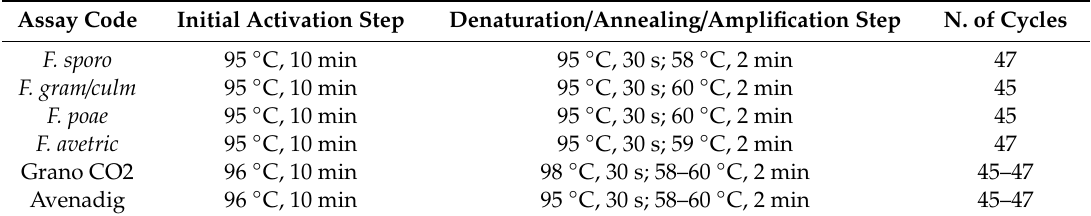
Table 2. Optimized amplification conditions applied in qPCR and dPCR assays.